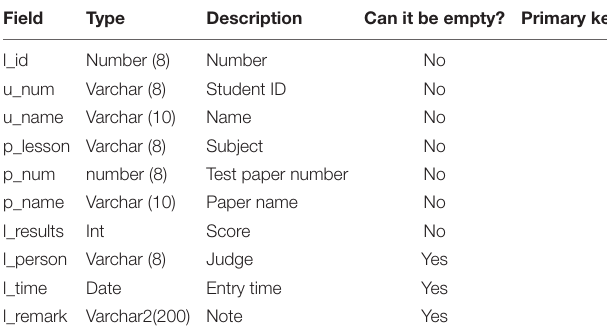
TABLE 3 | Achievement information